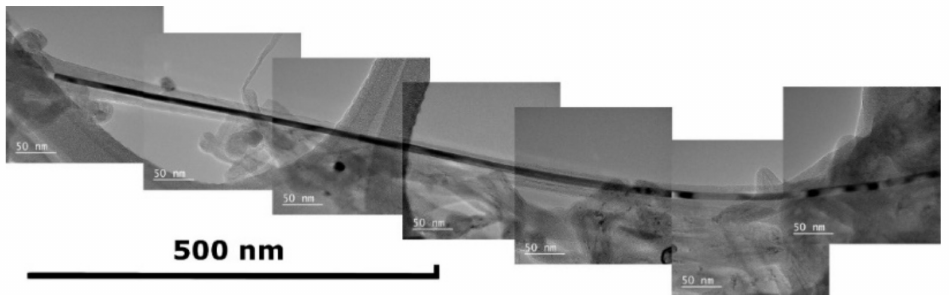
Figure 10. TEM image of a carbon nanotube with extra-long monocrystal Ni kernel